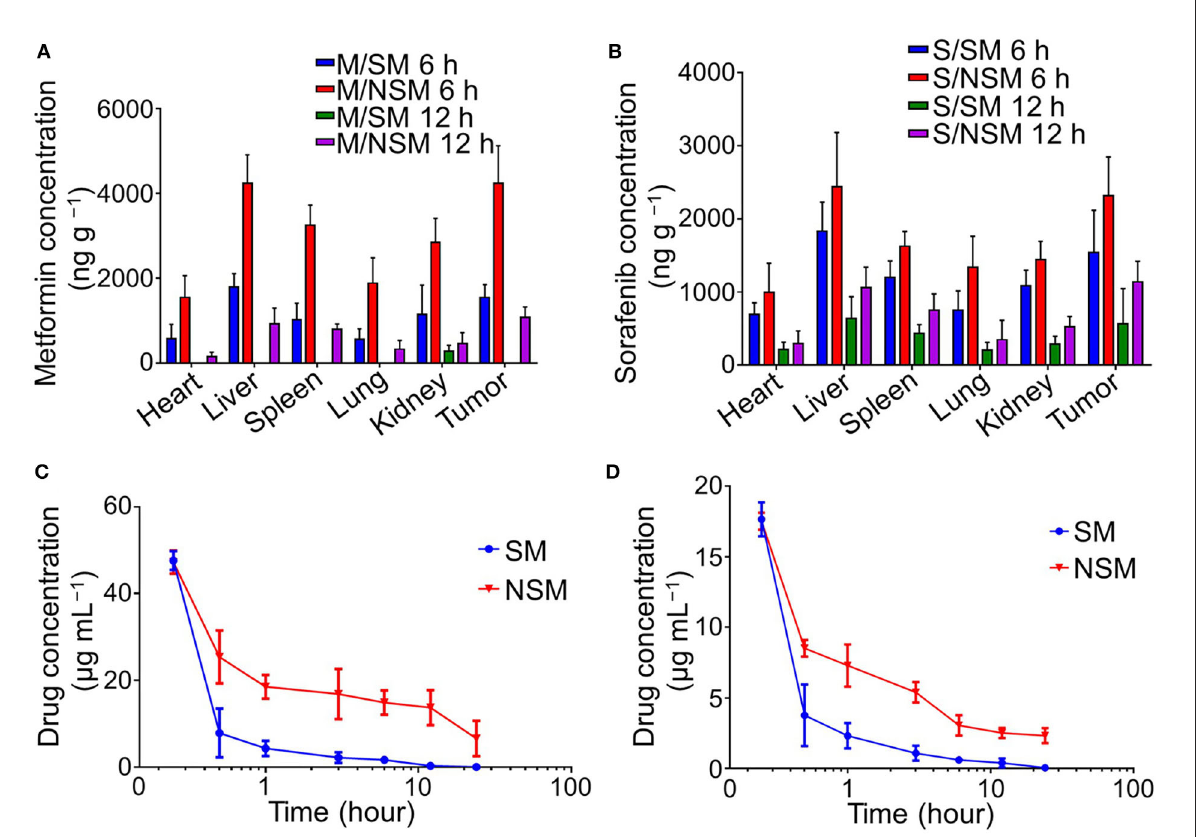
FIGURE3 Biodistribution and pharmacokinetics studies of Met and Sor. Biodistribution of (A) Met and (B) Sor in subcutaneous colon cancer mice model. Plasma pharmacokinetics of (C) Met and (D) Sor in SM and NSM